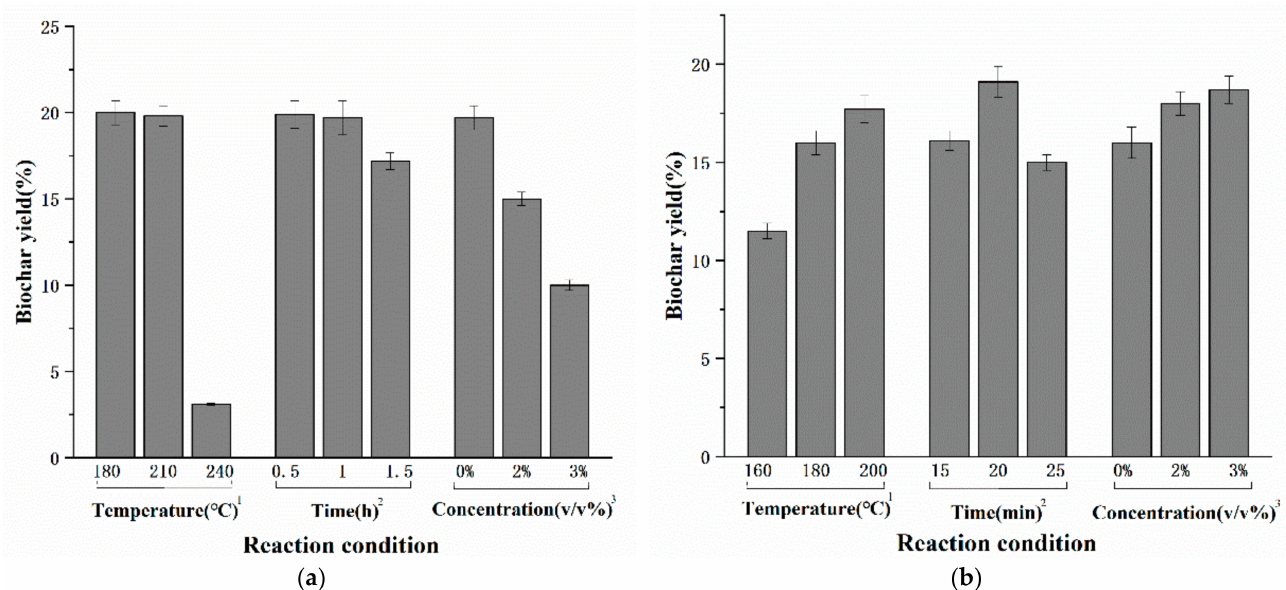
Figure 5. The yield of biochar produced from cooked soybean after the HTC process. ( a ): The HTC process is performed in HPR; ( b ): the HTC process is performed in MW. Values are presented as mean ± SD from three experiments. 1 Only the reaction temperature changed in the reaction conditions. The reaction time was 1 h, and the sulfuric acid concentration was 3 v / v %. 2 Only the reaction time changed in the reaction conditions. The reaction temperature was 210 ◦ C/180 ◦ C, respectively, and the sulfuric acid concentration was 3 v / v %. 3 Only the concentration of sulfuric acid changed in the reaction conditions.